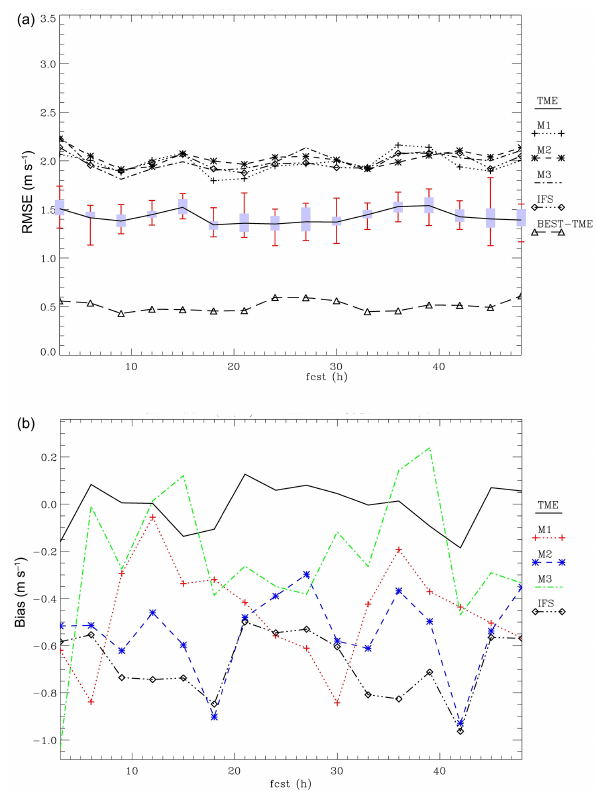
Figure 4. Same as Fig. 3 but for the summer